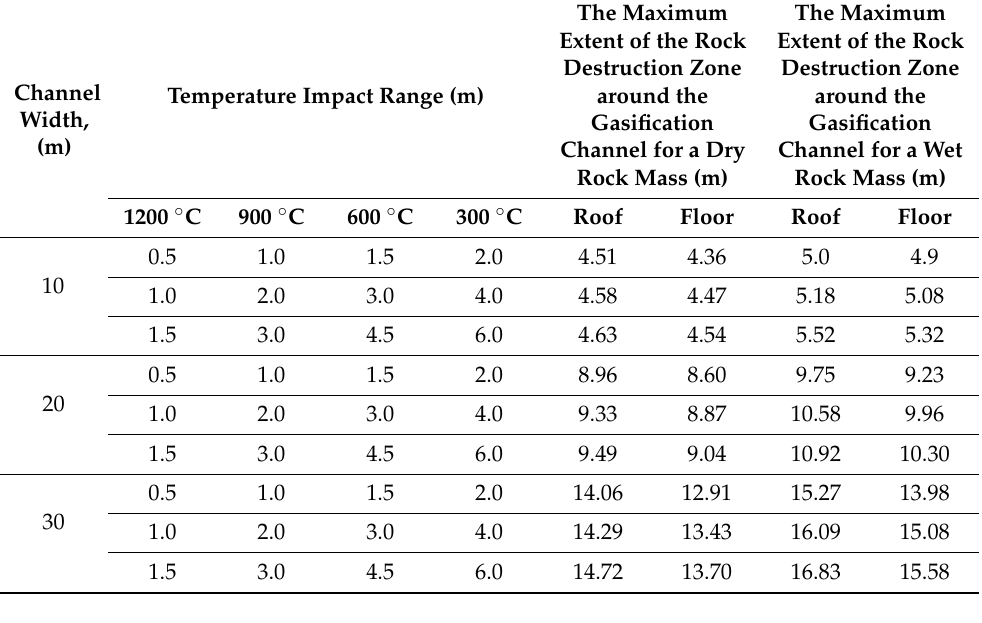
Table 2. Summary of the results of the range of the rock destruction zone around the gasification channel.